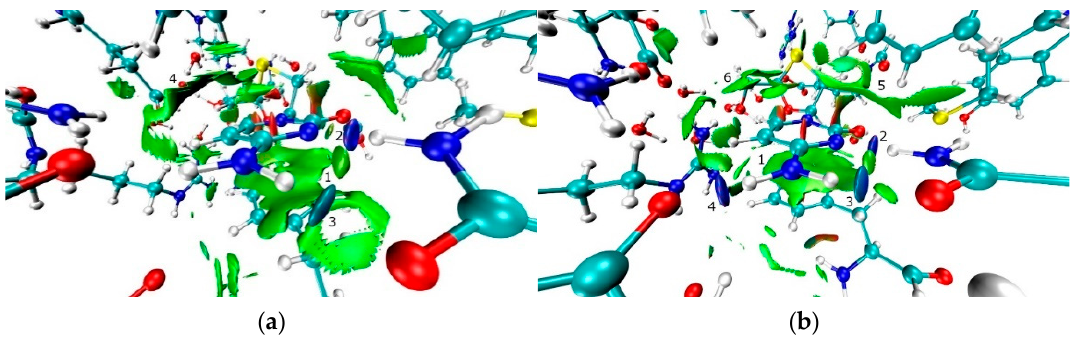
Figure 8. The isosurfaces of RDG function (0.35 a.u.) colored according to the λ 2 eigenvector ( − 0.02–0.04 a.u.) in the region of dihydroxypirimidine-2-one moiety of complexes A and B (( a ) and ( b ), respectively). Negative values are blue-colored while positive ones are red-colored. The stacking interactions appear near point 1, while strong N-H . . . N and N-H . . . O bonds are close to points 2 and 3, respectively, ( a ) or 2, 3, 4 ( b ). The C-H . . . π interactions are visualized at points 4 ( a ) or 5, 6 ( b ).